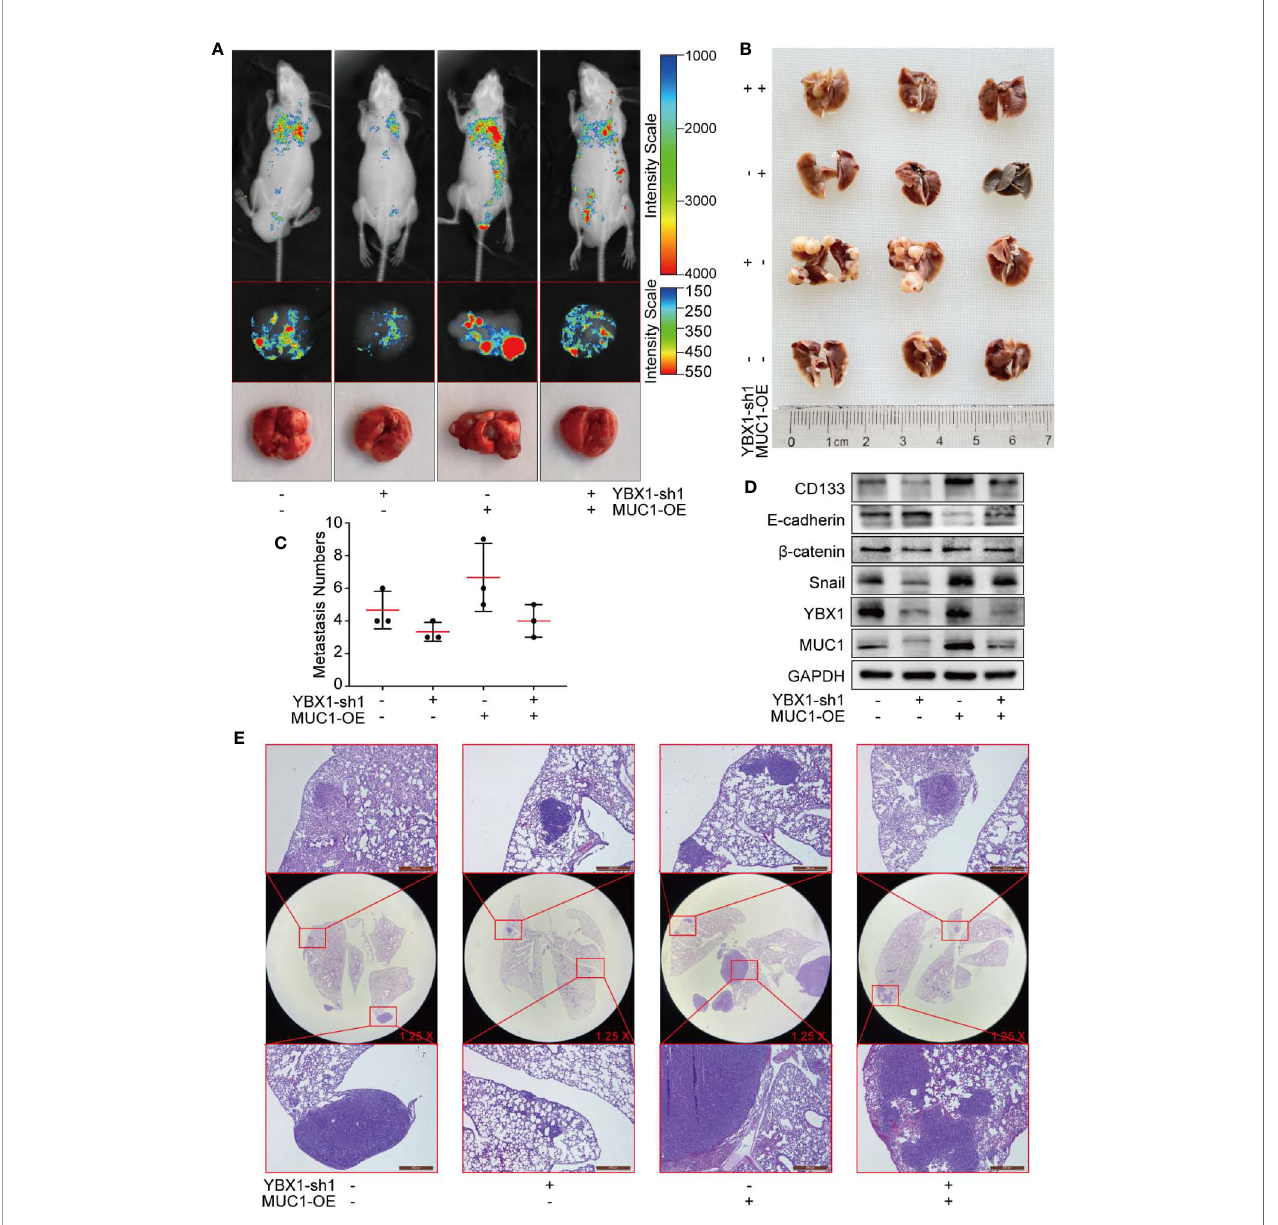
FIGURE 6 | YBX1 promotes tumor metastasis by upregulating MUC1 in lung cancer metastasis models. (A) The GFP-labeled A549 from different groups were injected into the tail vein of nude mice, and in vivo imaging was performed 45 days later. The lungs are dissected and imaged individually. (B) All whole lung was fi xed with 4% paraformaldehyde, and the surface of the fi xed metastases was white granular. (C) The number of metastases in the lungs of each nude mouse was counted. (D) The expression of YBX1, MUC1, CD133, E-cadherin, b -catenin, and Snail within xenografts in the different groups was detected by Western blot. (E) The lung adenocarcinoma metastasis morphology showed by HE staining. Scale bars= 500 m m. N= 3 mice/group. Original magni fi cation of the whole lung: